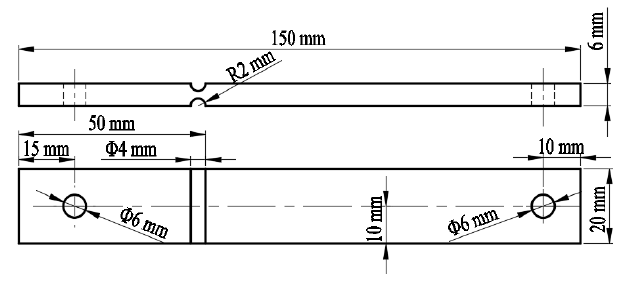
Figure 4. Schematic diagram of the specimen structure.